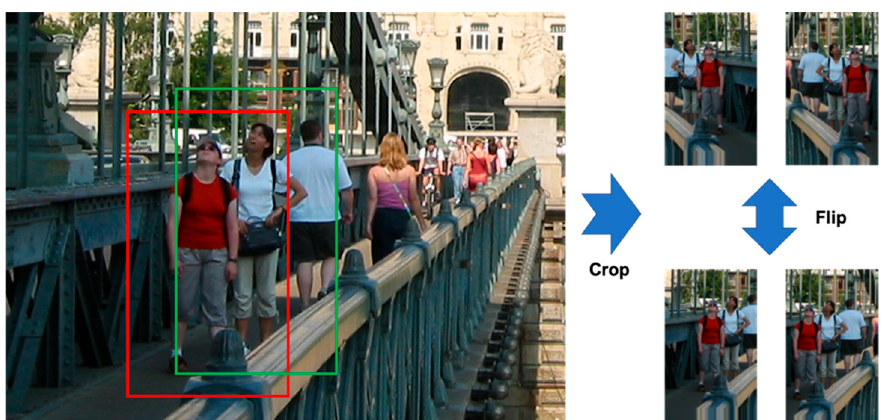
Figure 5. Perform data augmentation for input of detection system. Table 1. Experimental results for benchmark